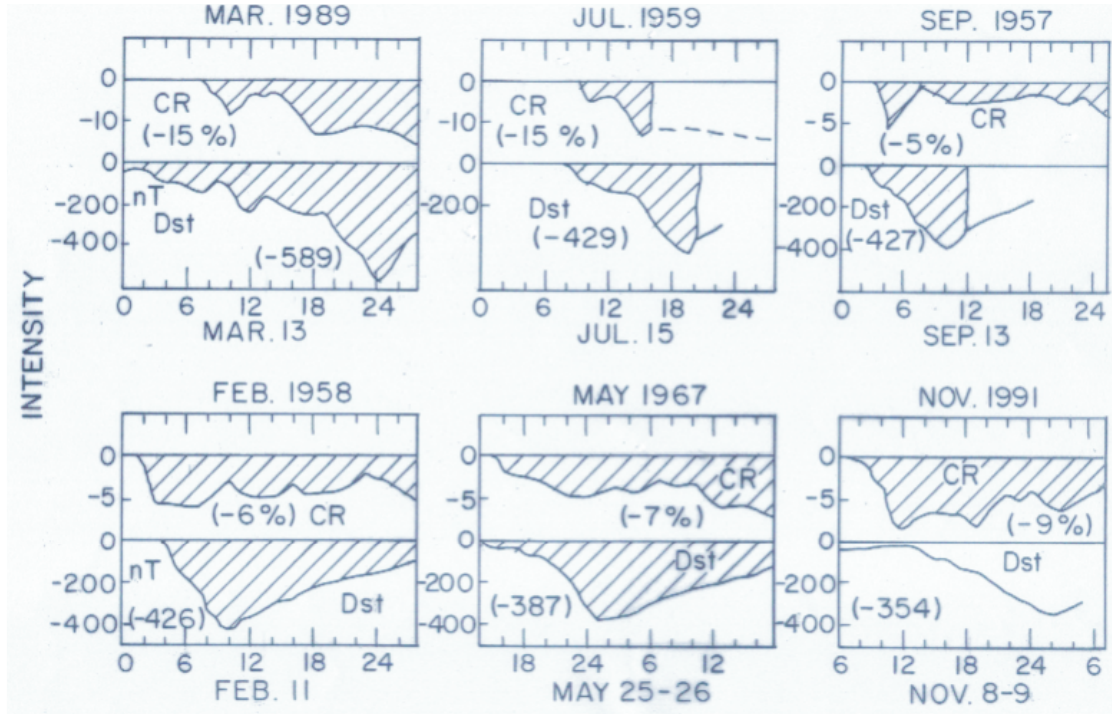
Fig. 7. Plots of hourly values of CR depressions (FDs) and geomagnetic Dst for the six largest Dst events 13 March 1989, 15 July 1959, 13 September 1957, 11 February 1958, 25–26 May 1967 and 8–9 November